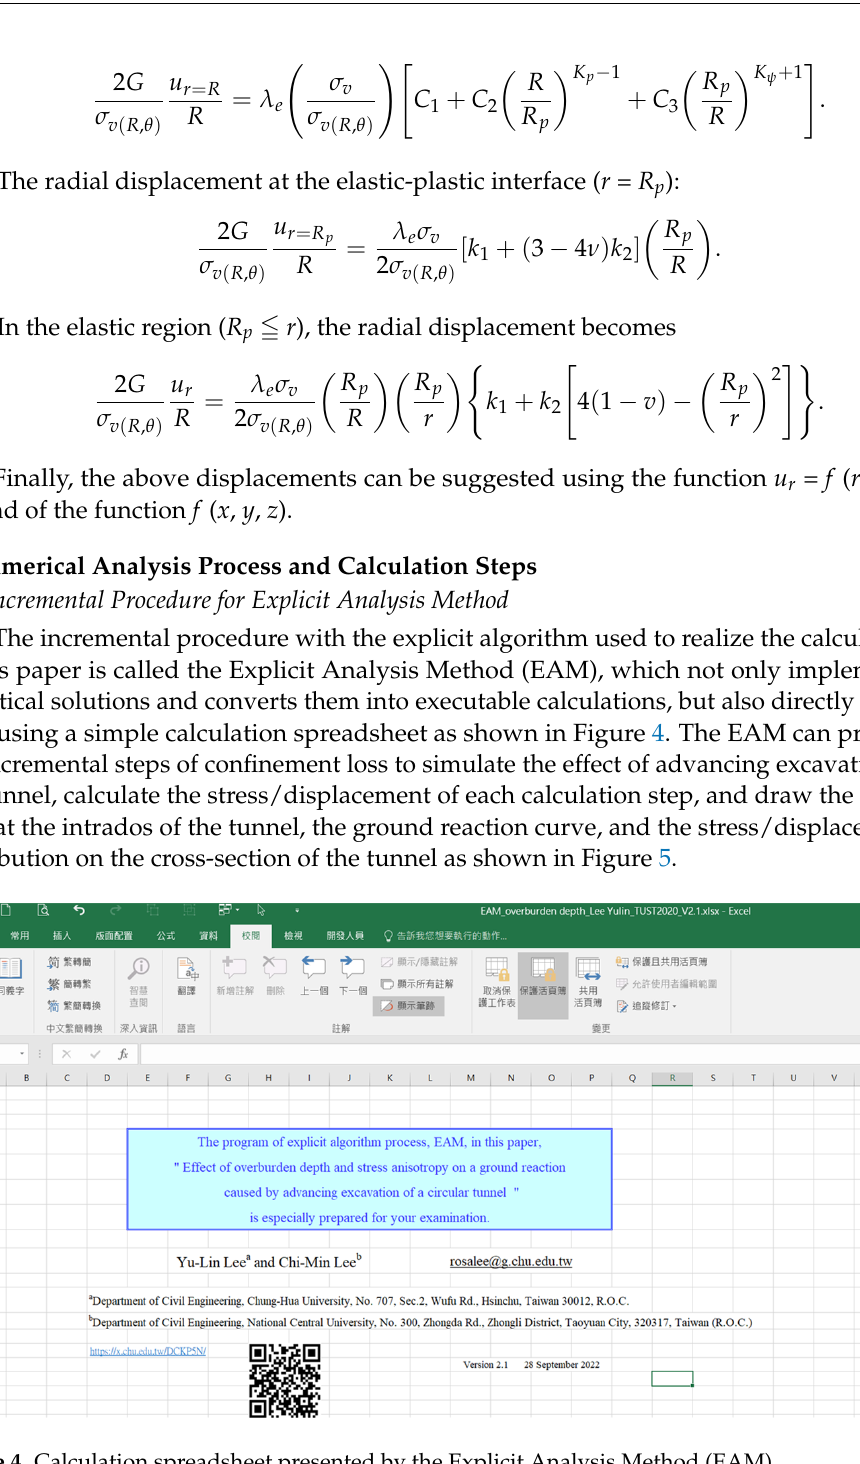
Figure 4. Calculation spreadsheet presented by the Explicit Analysis Method (EAM).